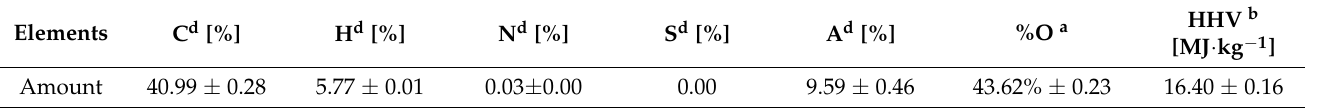
Table 1. Main characteristics of PH.